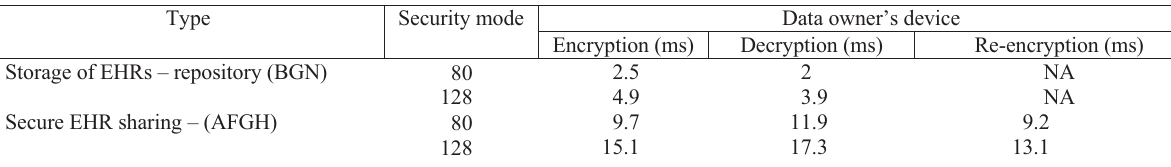
Table 2. Performance summary – data owner’s device